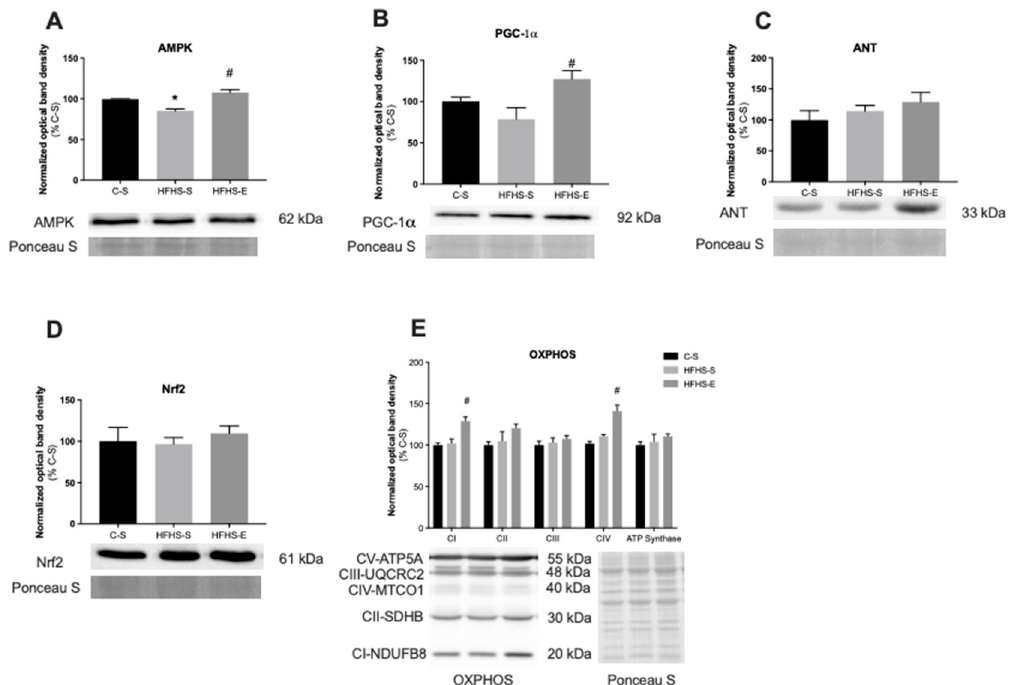
Figure 4. Relative protein content of 5 ′ adenosine monophosphate-activated protein kinase (AMPk) ( A ); peroxisome proliferator-activated receptor- γ coactivator-1 α (PGC-1 α ) ( B ); and adenine nucleotide translocator (ANT) ( C ). Nuclear factor-erythroid factor 2-related factor 2 (Nrf2) ( D ) and oxidative phosphorylation subunits (OXPHOS) ( E ) in the soleus muscle. Offspring from the control diet sedentary group (C–S); offspring from the high-fat, high-sucrose diet sedentary group (HFHS–S); offspring from the high-fat, high-sucrose diet exercised group (HFHS–E), n = 6. Data are expressed as the mean ± SEM. Statistically significant differences ( p ≤ 0.05) are indicated as follows: * vs. C–S, # vs. HFHS–S.